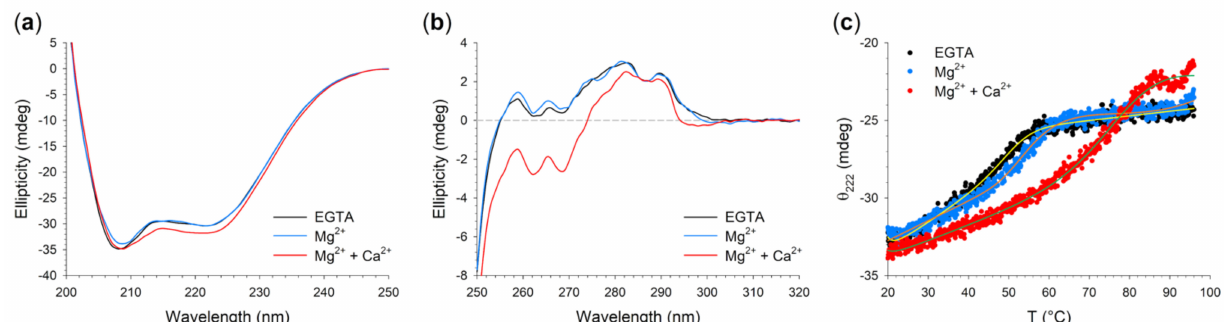
Figure 6. Structural and stability changes of N104K-G105R upon ion binding assessed by Circular Dichroism (CD) spectroscopy. ( a ) Far UV CD spectra of 10 µ M N104K-G105R in the presence of 300 µ M EGTA (black) and after serial additions of 1 mM Mg 2+ (blue) and 600 µ M Ca 2+ (red). ( b ) Near UV CD spectra of 42 µ M N104K-G105R in the presence of 500 µ M EGTA (black) and after serial additions of 1 mM Mg 2+ (blue) and 1 mM Ca 2+ (red). ( c ) Thermal denaturation profiles of 10 µ M N104K-G105R in the presence of 300 µ M EGTA (black), 300 µ M EGTA + 1 mM Mg 2+ (blue) and 1 mM Mg 2+ + 300 µ M free Ca 2+ (red). CD spectroscopy measurements were conducted in 20 mM Tris-HCl pH 7.5, 150 mM KCl, 1 mM DTT buffer. Thermal denaturation profiles were collected by monitoring the ellipticity at 222 nm between 20